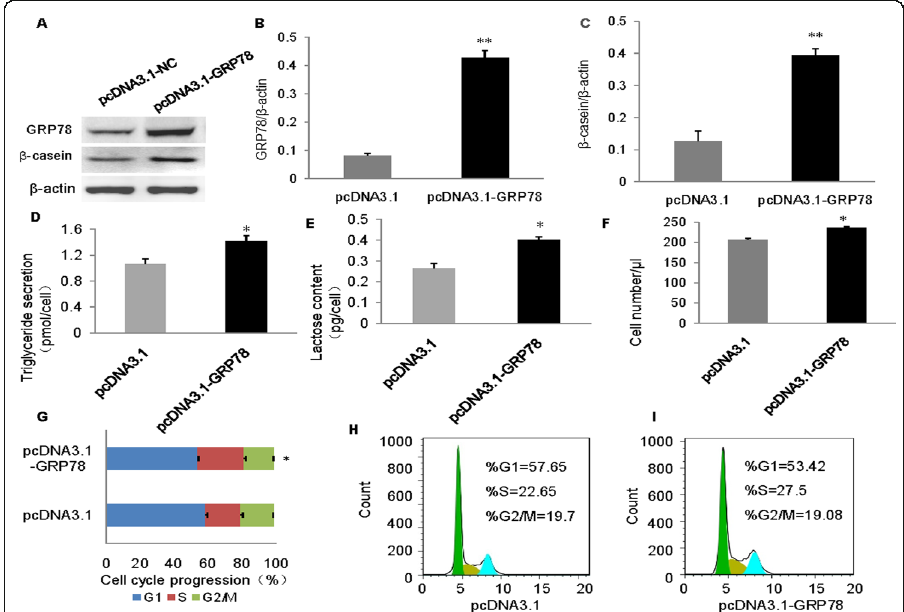
Fig. 3 Overexpression of GRP78 promotes milk biosynthesis and cell proliferation. a Western blot analysis of GRP78 and β -casein in BMECs transfected with pcDNA3.1-GRP78 vector. Cells transfected with the empty vector (pcDNA3.1) were used as negative controls. b and c Relative fold change of protein levels (proteins/ β -actin) of GRP78 ( b ) and β -casein ( c ) determined via western blotting and quantified using grayscale scanning. d Triglyceride (TG)contents in the culture medium. e Lactose contents in the culture medium. f Cell numbers were measured using a cell counter. g , h and i Cell cycle transition measured ( g ) and analyzed ( h and i ) via flow cytometry. Data represent the means ± SEfrom three independent experiments. * p < 0.05;** p <